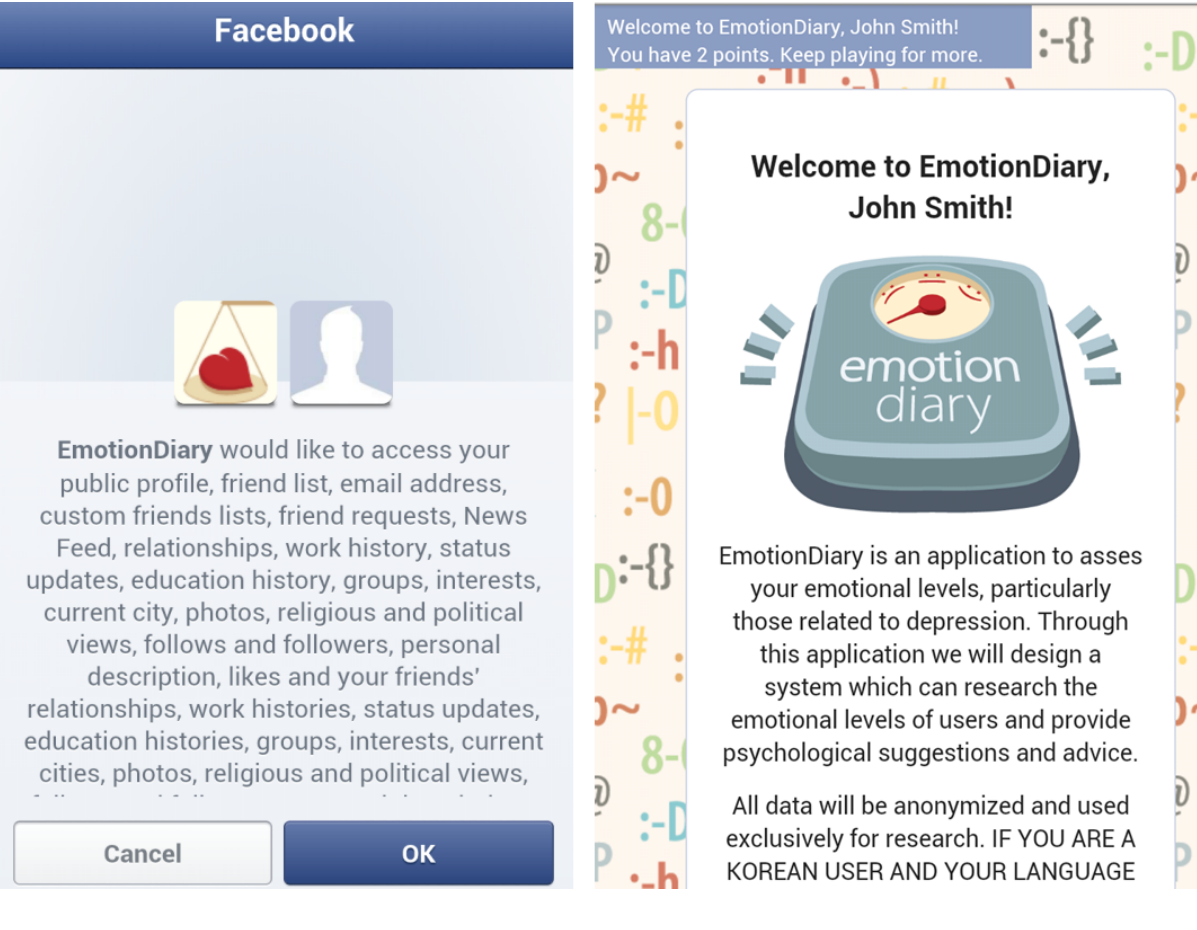
Figure 1. EmotionDiary screenshots: asking permission for data access and the welcome